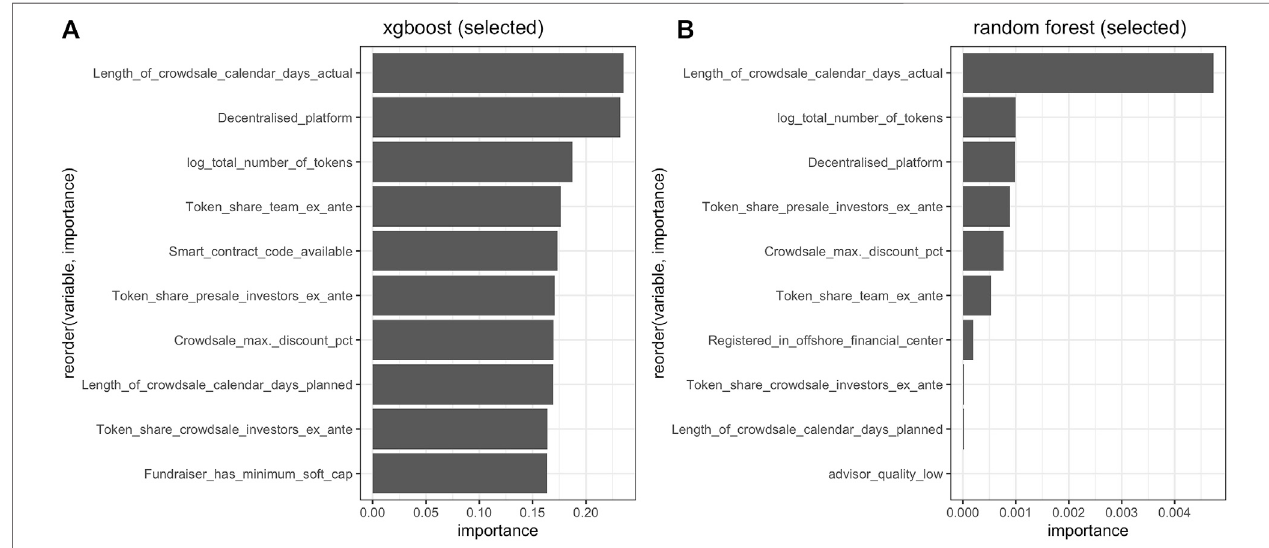
FIGURE 5 | Feature importance for xgboost and random forest on selected variables (10 most important